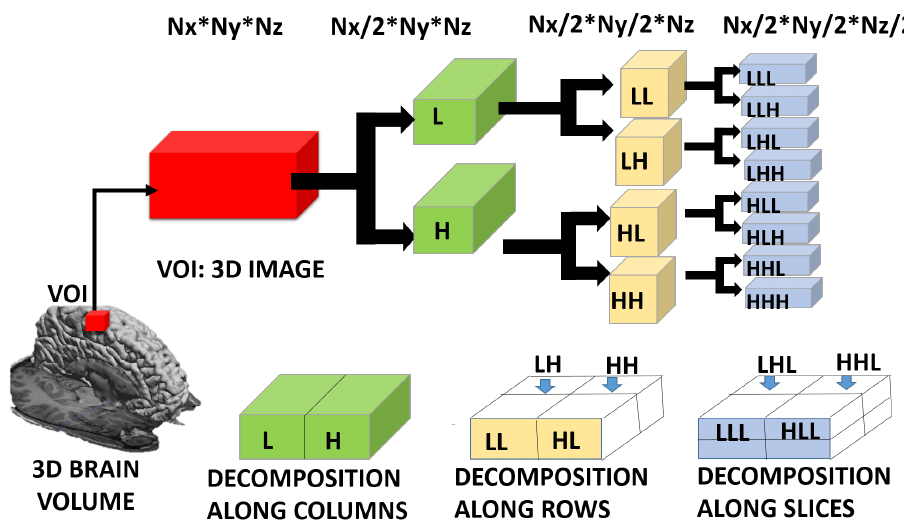
Figure 4. Operating mode of the 3D-DWT wavelet decomposition applied to a specific VOI.